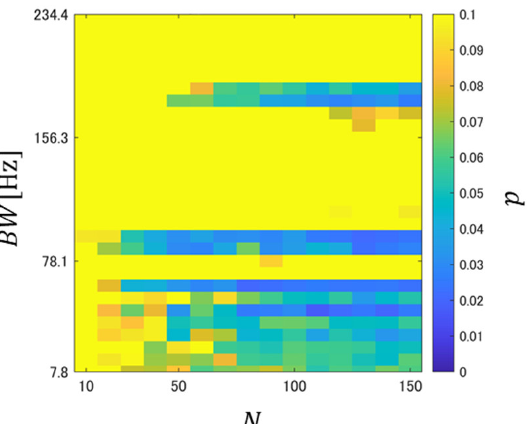
Figure 4. Relationship of p of PFHS in BWI-AWI and BSI-ASI when the number of BS episodes and BW were varied during the creation of PFH. The colors represent significance levels; a yellow color indicates a significance level of ≥0.1.